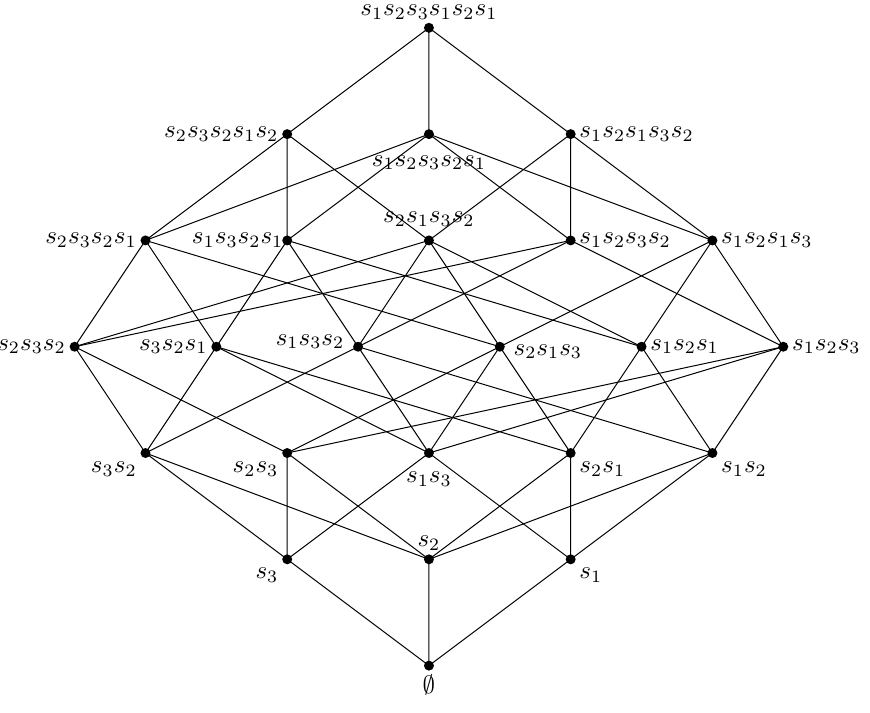
Fig. 1: The Bruhat order of the symmetric group S 4 , where each element is labeled by one of its (possibly many) reduced